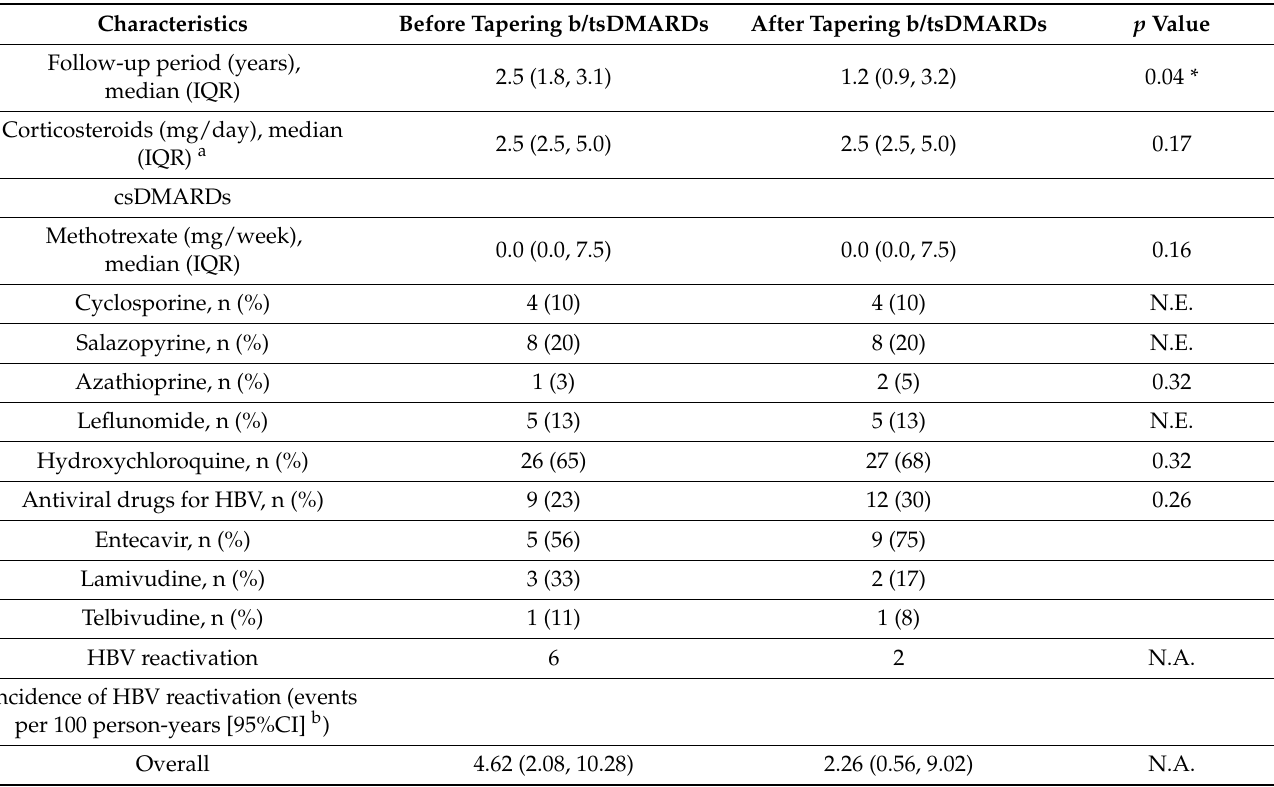
Table 2. HBV reactivation in the 40 RA patients with CHB before and after tapering